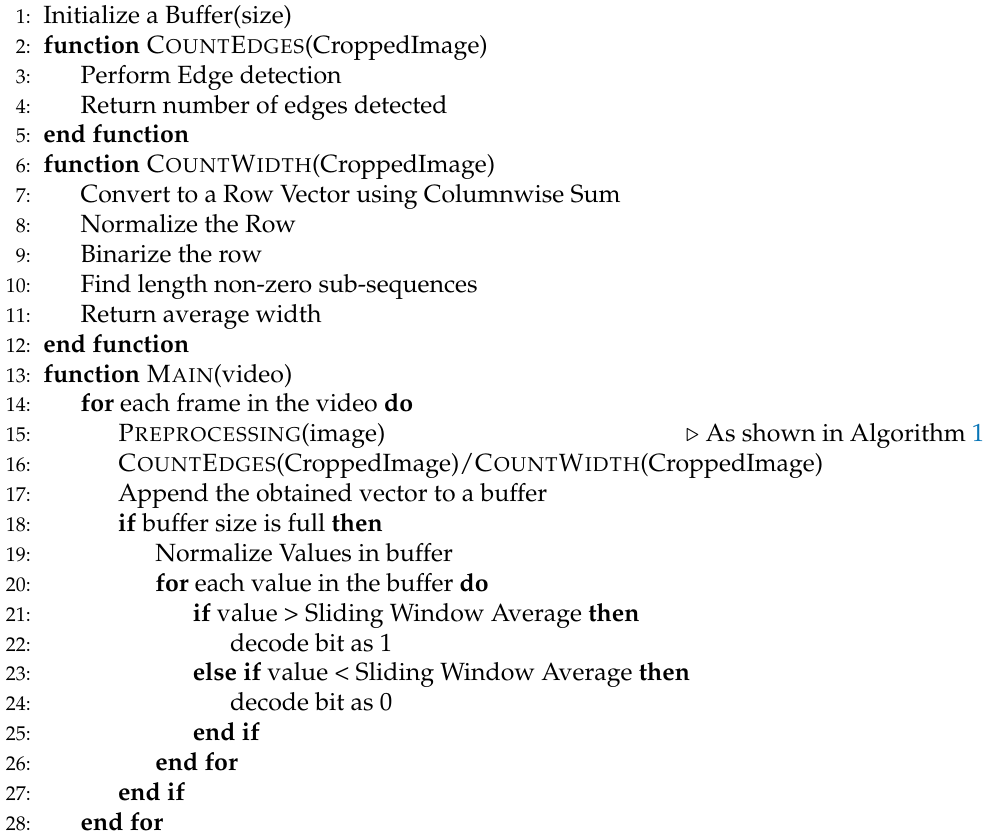
Algorithm 5 BFSOOK Demodulation for VLC-OCC